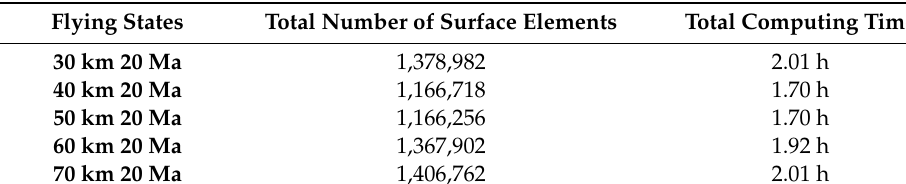
Table 1. Computational time of BRCS for selected flying states.